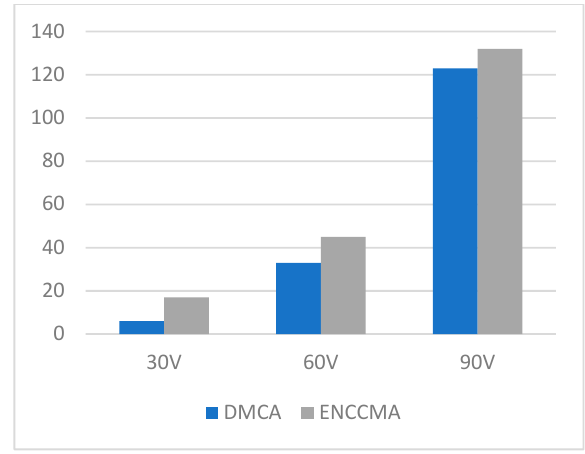
Figure 9. Data collision for the city environment.